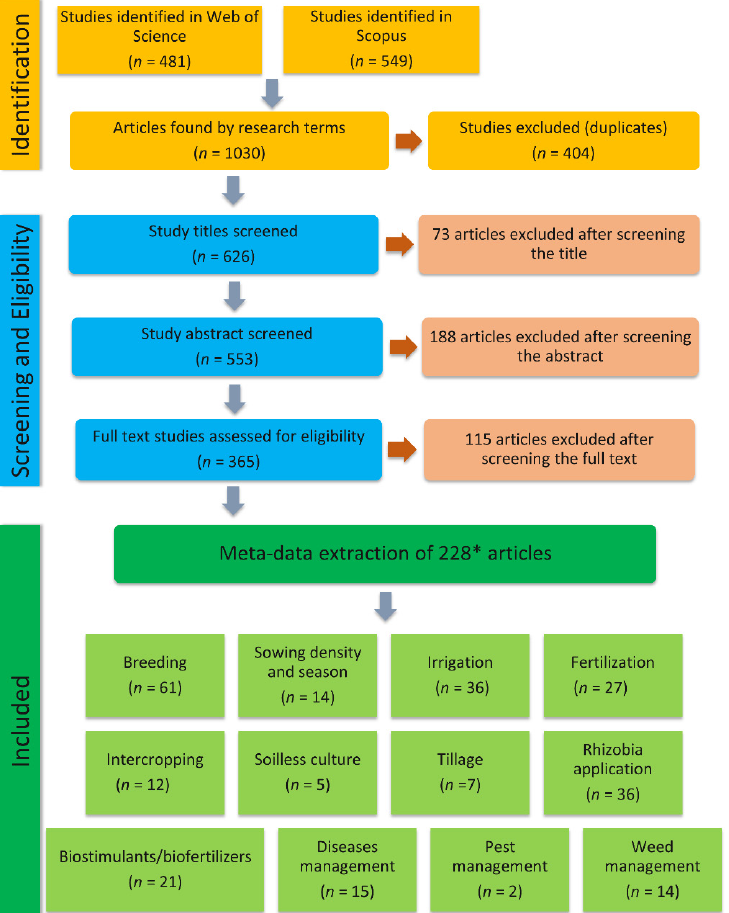
Figure 1. Flow chart of the screening and selection process followed for the inclusion of the studies in the systematic review. Where n denotes the number of studies results for each treatment. * Some studies reported results from more than one treatment and therefore the sum of the publications appearing in the 12 treatments (250) is greater than the total number of publications assessed in the study (228).